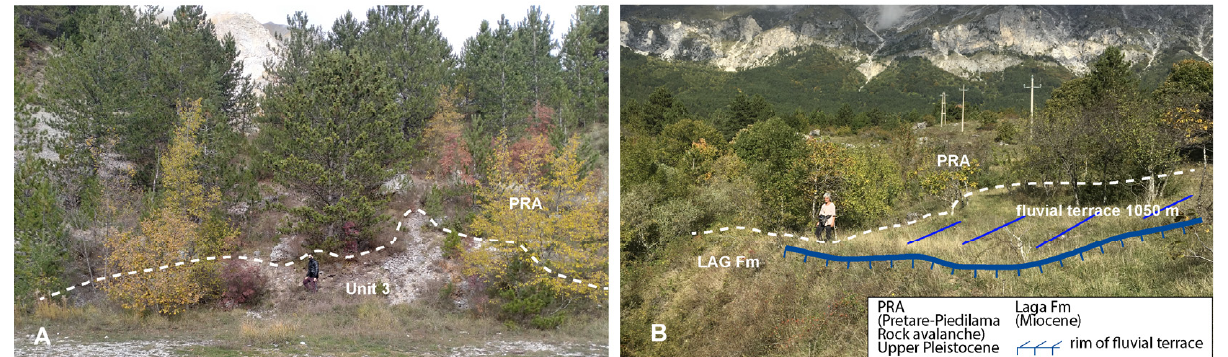
Figure 8. ( A ) Details of the erosional bound between the PRA deposit (Pretare-Piedilama roch avalanche) and the unit 3 (slope detritus) northern to the Pretare village. ( B ) Panoramic view of the contact between the PRA deposit remnants and the LAG bedrock. The PRA deposits rest on a terraced erosional surface placed at about 1050 m of elevation a.s.l.